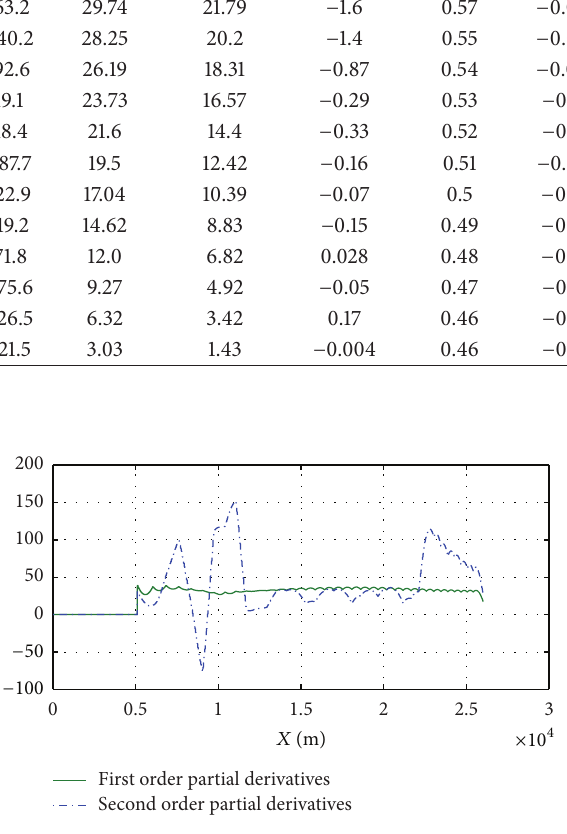
Figure 7: Predictive results with different order partial derivatives.